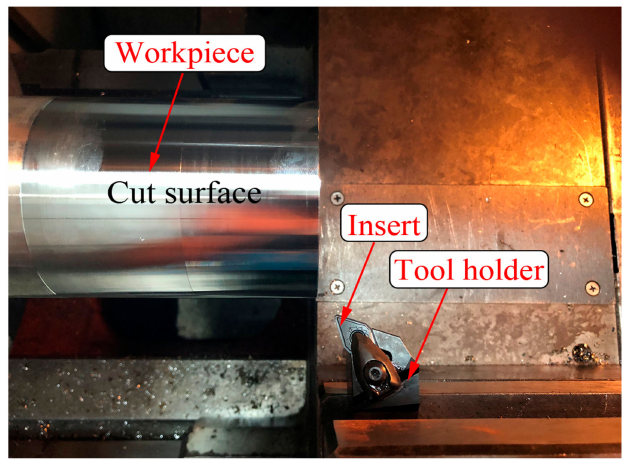
Figure 7. The experimental details of turning Inconel 718 pipes.